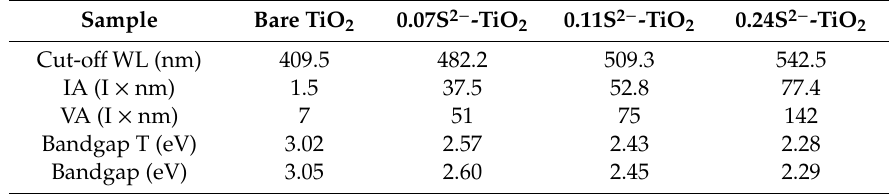
Table 4. The cut-o ff wavelength, intrinsic absorption intensity (IA), visible light absorption intensity (VA), bandgap of theoretical value (Bandgap T) and bandgap of TiO 2 -doped with di ff erent ratios of anionic S 2 −